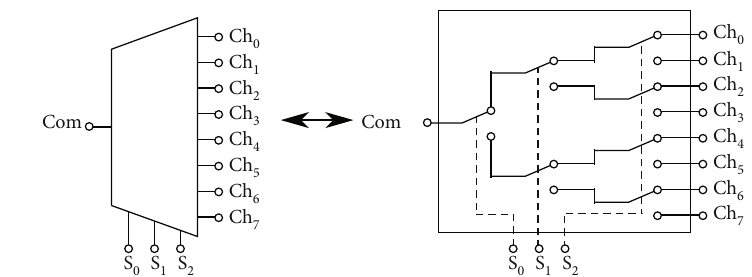
Figure 11: Multiplexed veri fi cation equipment.